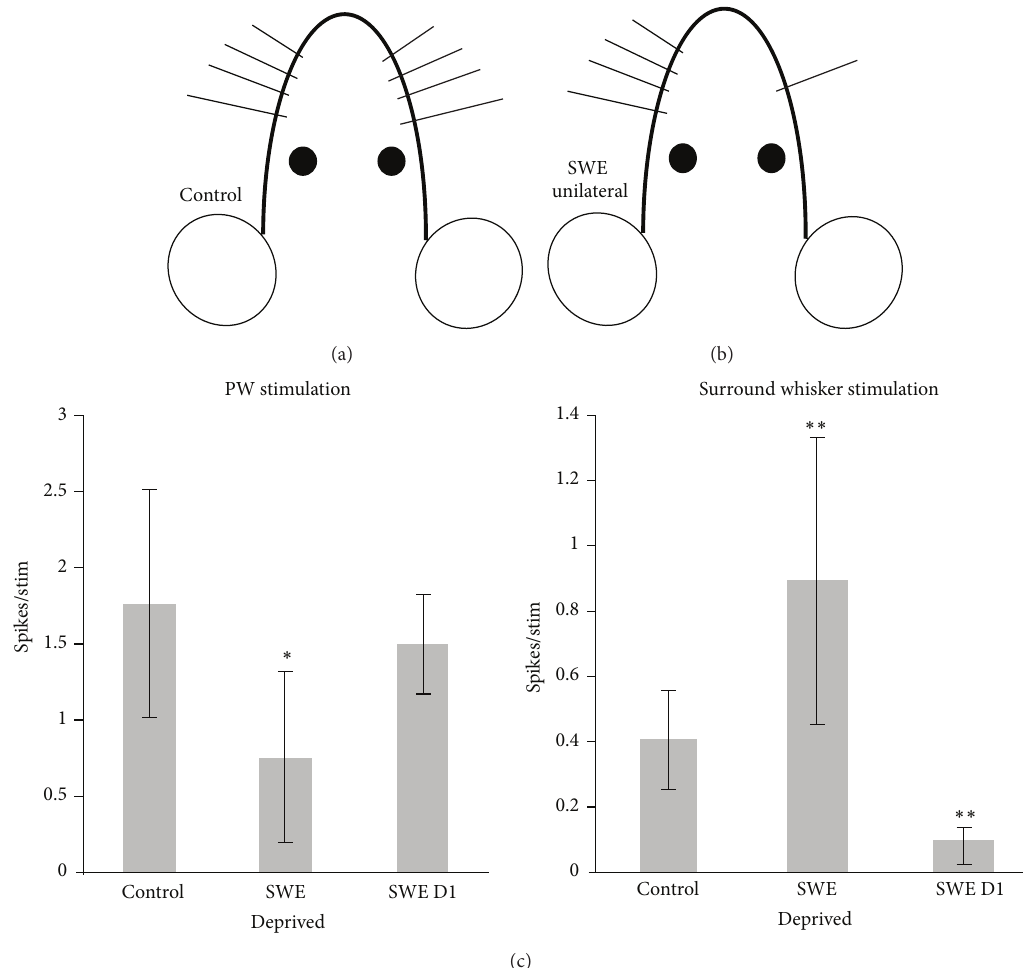
Figure 3: Plasticity in the barrel cortex can be induced by single-whisker experience (SWE). All whiskers except the D1 whisker were removed from one side of the face after P28 (a). Whiskers were kept deprived for 18 days followed by 5–8 days of deprived whisker regrowth, then whisker driven responses were recorded from the barrel cortex in anaesthetised mice. When whiskers were stimulated, recordings were taken from that whisker’s corresponding principal whisker column (PW; b) and the immediately surrounding columns (c). In the principal whisker column, responses to stimulation of deprived whiskers but not the intact D1 whisker were significantly downregulated compared to those in the undeprived, control animals. However, surround responses driven by stimulation of the D1 whisker were significantly increased, while responses of the D1 column driven by the stimulation of deprived whiskers were significantly suppressed compared to undeprived, control animals ( ∗ 𝑝 < 0.05 , ∗∗ 𝑝 < 0.01 , Mann-Whitney 𝑈